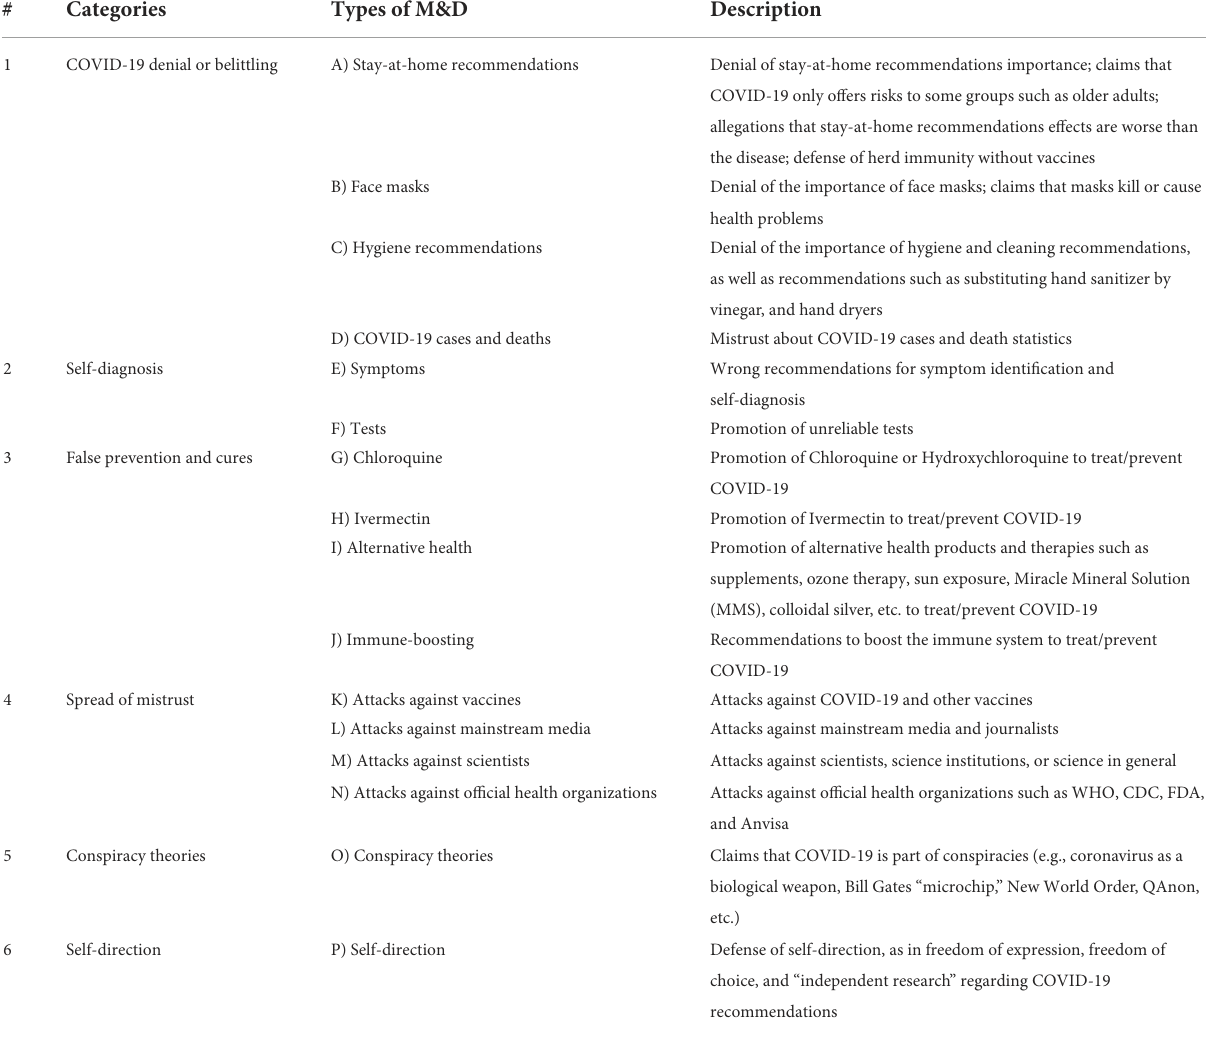
TABLE 1 COVID-19 M&D classification